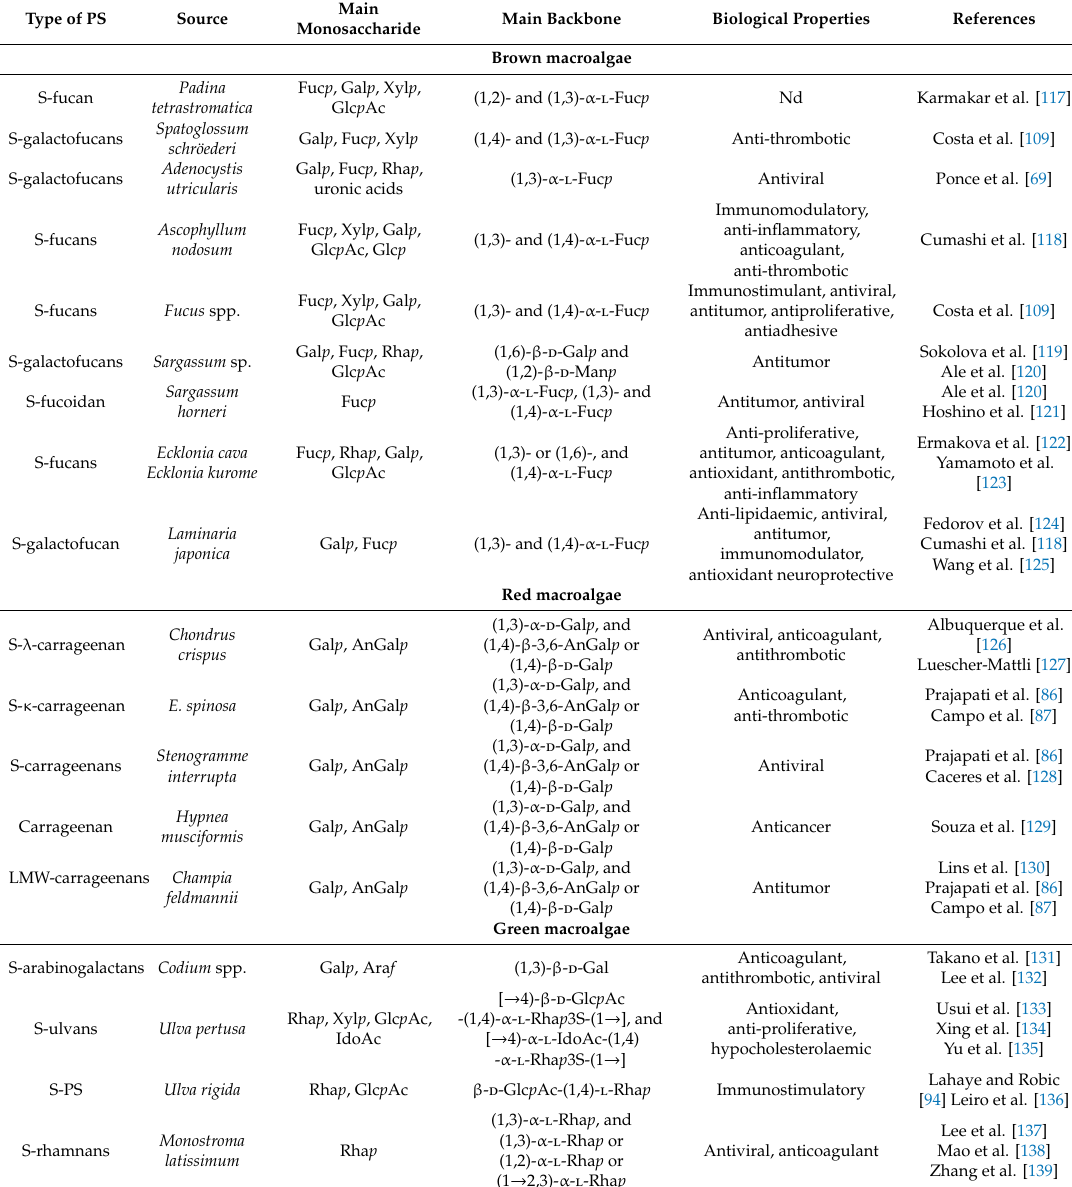
Table 2. Biological properties of algal bioactive